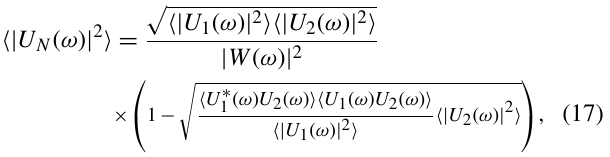
Figure 13. Installation for measuring the intrinsic noise of molecular–electronic hydrophones. 1 – unbundled seismic founda- tion, 2 – thick-walled metal tank with water, 3 – foam cap, 4 – foam base, 5 tested molecular and electronic hydrophones, 6 – data ac- quisition system, 7 – laptop with special software.